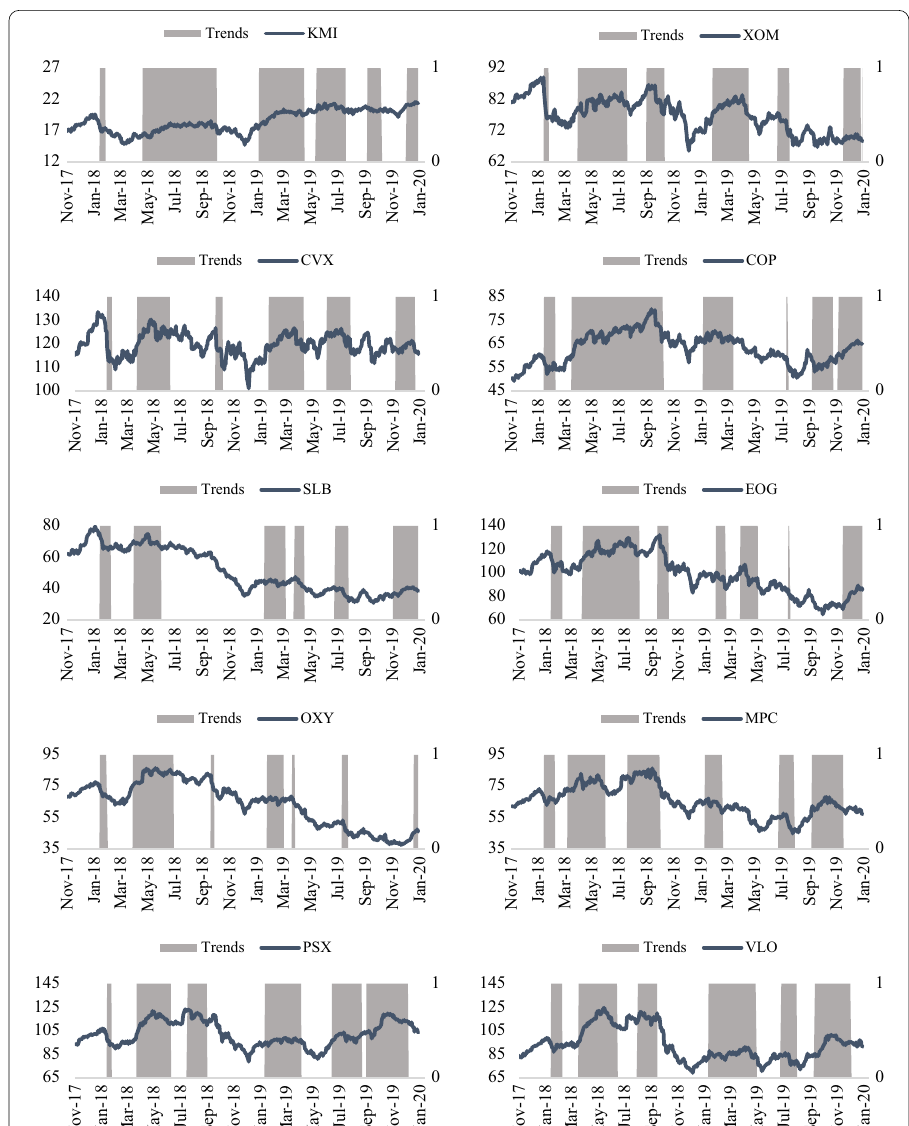
Fig. 5 Energy stock prices and trends (Nov 2017–Jan 2020). Note: The company stocks (trading symbols) include Kinder Morgan Inc (KMI), Exxon Mobil (XOM), Chevron Corp (CVX), ConocoPhillips (COP), Schlumberger Ltd (SLB), EOG Resources (EOG), Occidental Petroleum (OXY), Marathon Petroleum Corp (MPC), Phillips 66 (PSX), and Valero Energy Corp (VLO). A trend is assumed to come into existence if the slope of the last 50 days is greater or less than zero. An upward (downtrend) trend is in place when the slope is positive (negative). The grey (white) areas are periods with uptrends (downtrends). Source : S&P 500 Dow Jones Indices, Coinmarketcap, and